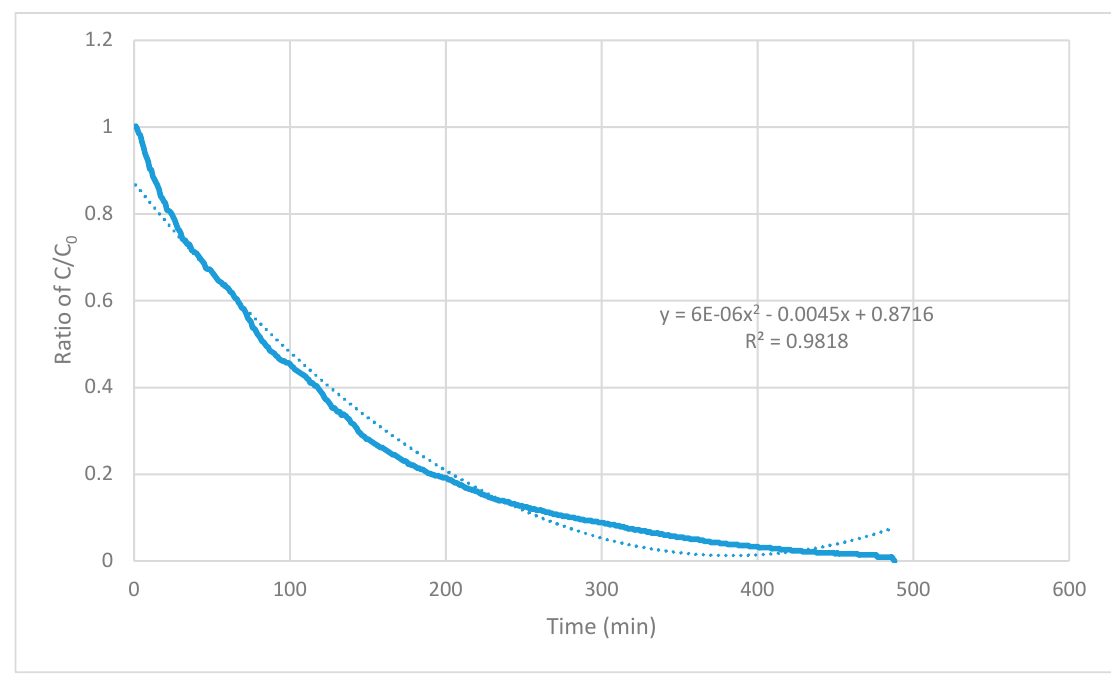
Figure 8. Excel-fitted line and calculated equation for data from 2 February 2015. Table 3. Summary of parameters for lines fitted to data points, (C/C 0 ) versus time (min), using the second-order polynomial model.